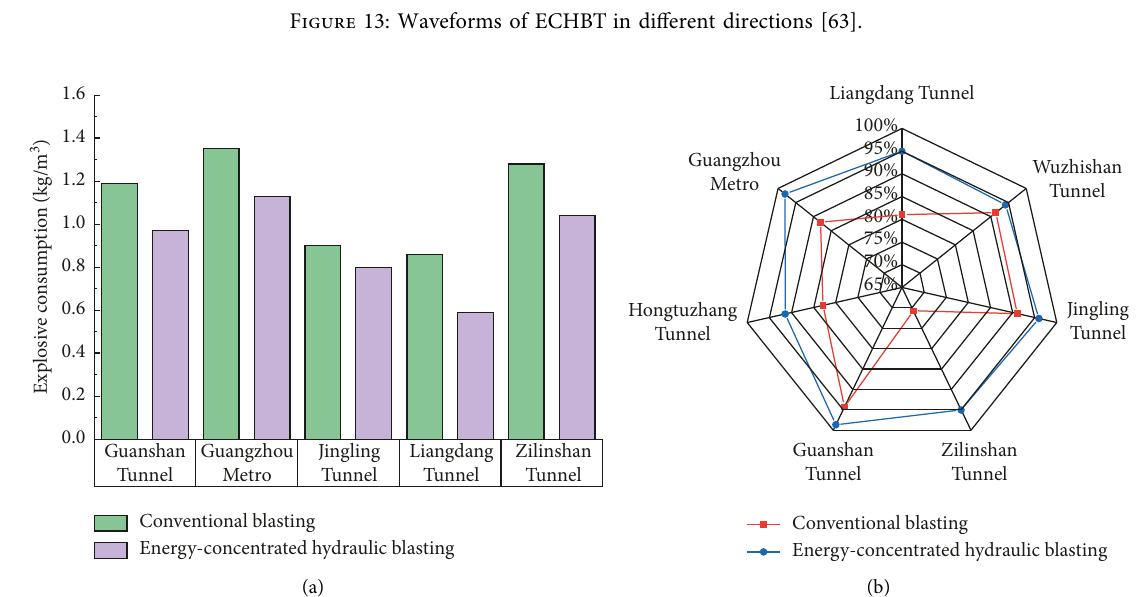
Figure 14: Comparison of (a) explosive consumption and (b) blasthole utilization [45–65].